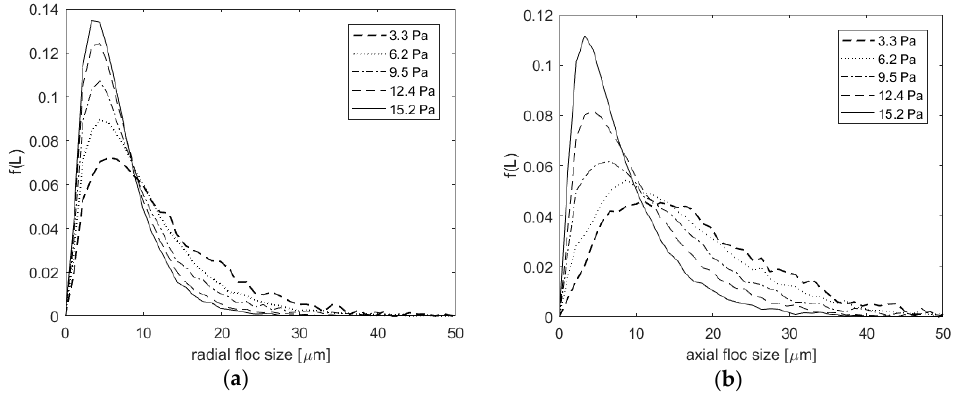
Figure 6. ( a ) Radial and ( b ) axial floc size distributions calculated with the run-length method [8]. Both axial and radial floc sizes decrease with an increasing wall shear stress.